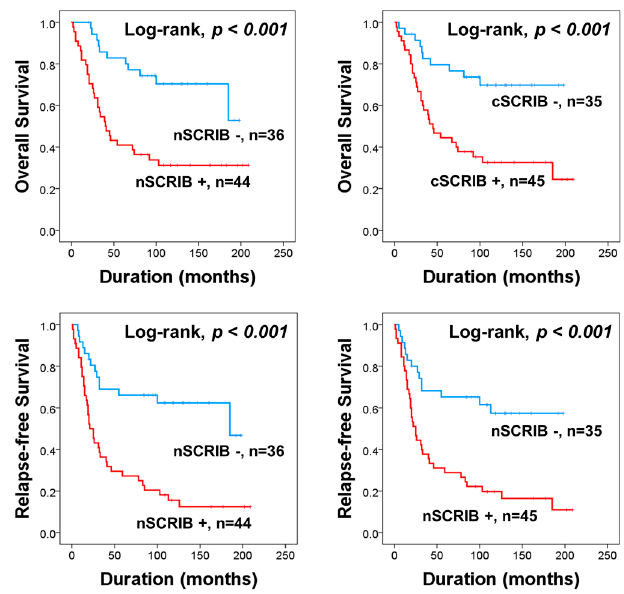
Figure 4. Survival analysis of ovarian carcinoma patients who received adjuvant chemotherapy. Kaplan-Meier survival curves for overall survival and relapse-free survival according to the nuclear and cytoplasmic expression of SCRIB in 80 ovarian carcinoma patients who received adjuvant chemotherapy.